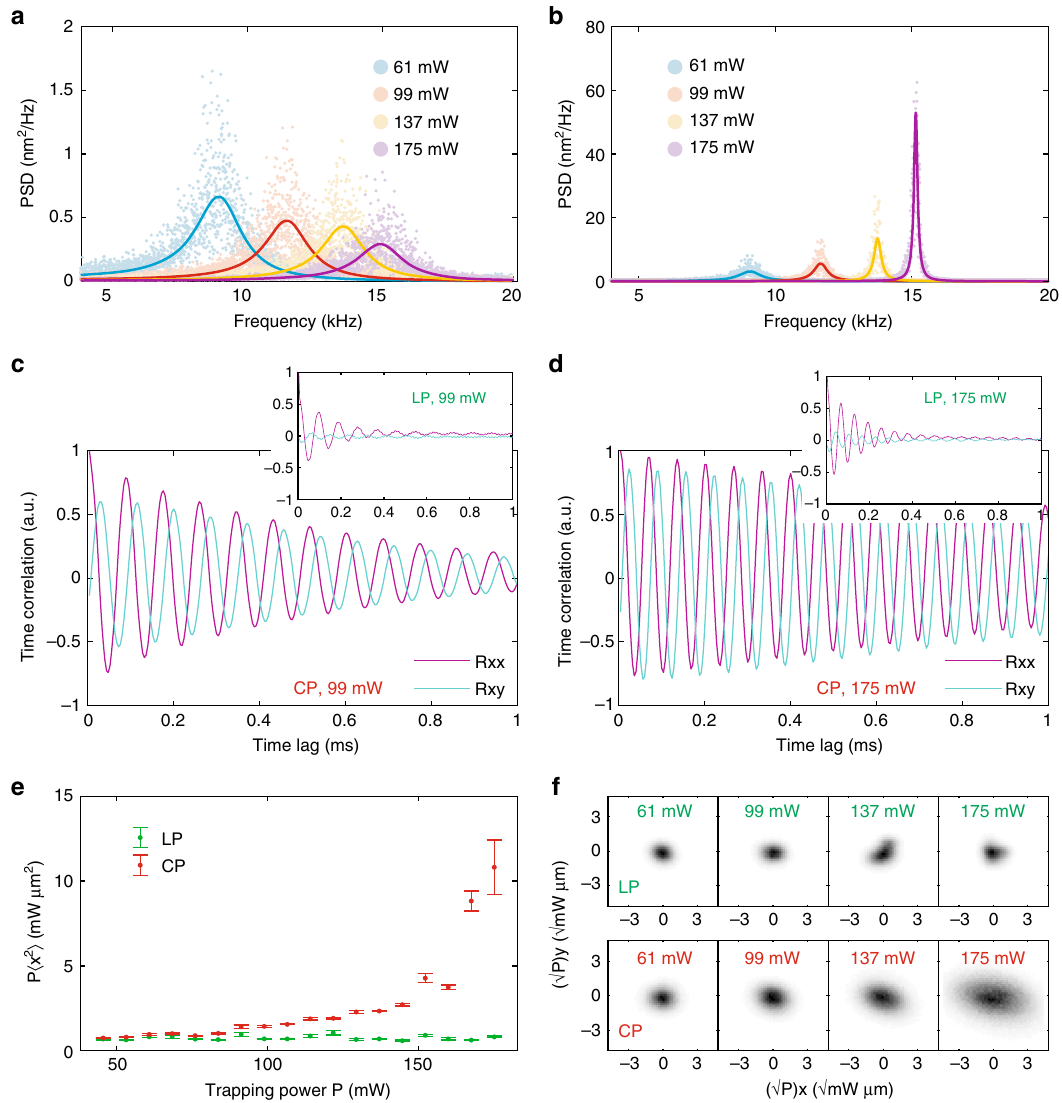
Fig. 2 Characteristics of the stochastic motion in Regime I. Power spectral densities for particle positions for a LP b CP beams. In the latter case, spin momentum drives a resonance, increasing the peak height and narrowing its width. c , d Time-dependent variance of particle coordinates at two different beam powers. 〈 x ( t + τ ) x ( t ) 〉 and 〈 x ( t + τ ) y ( t ) 〉 are π /2 phase shifted, indicating a tendency toward circular motion. Increasing the power increases the mean frequency of rotation and increases the time constant governing the loss of coherence of the oscillation. Results for linearly polarized beams are inset. e Graph showing the product of the position variance with power, as a function of power ( P 〈 x 2 〉 v P ), for LP and CP. Error bars show the standard error of the mean. f Measured probability distribution of the trapped particle in the transverse plane, scaled by the square root of the beam power for a linearly polarized trap (top row) and a circularly polarized trap (lower row). Variation of this distribution with beam power indicates deviation from thermodynamic